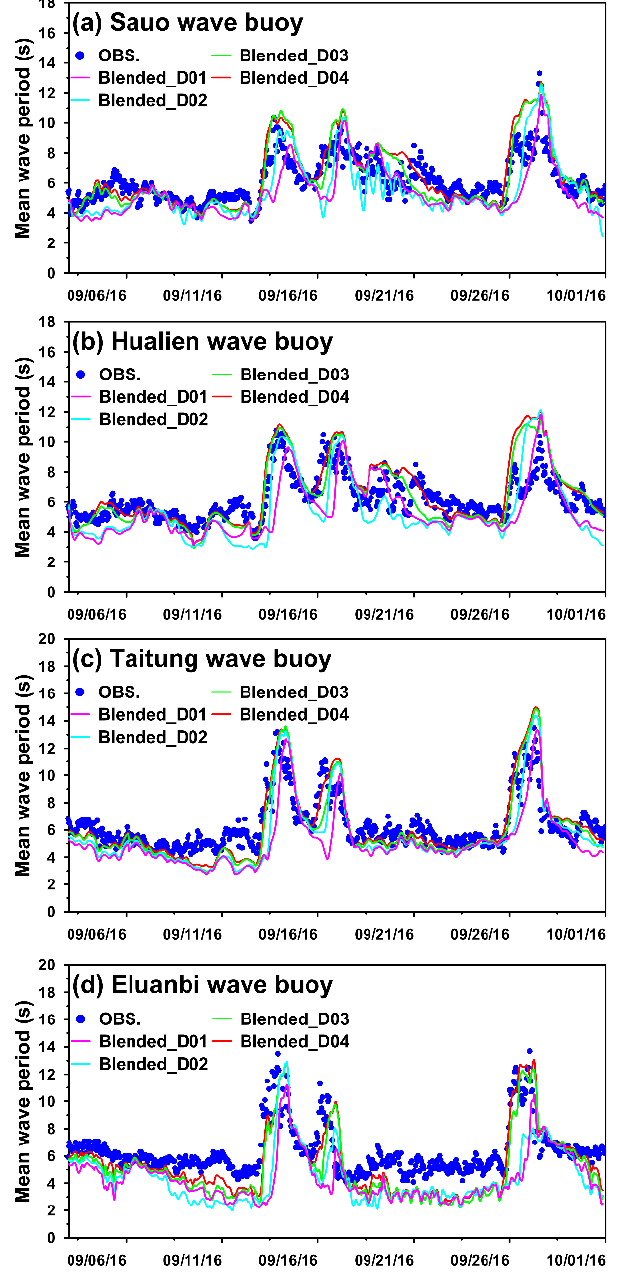
Figure 13. Comparison of the simulated and measured mean wave periods at the ( a ) Suao, ( b ) Hualien, ( c ) Taitung, and ( d ) Eluanbi wave buoys using the four computational domains and blended wind fields.